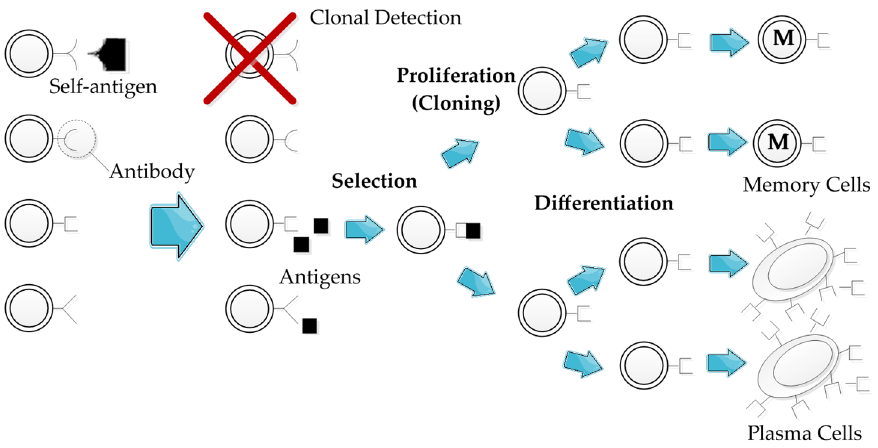
Figure 2. The selection process of antibodies.